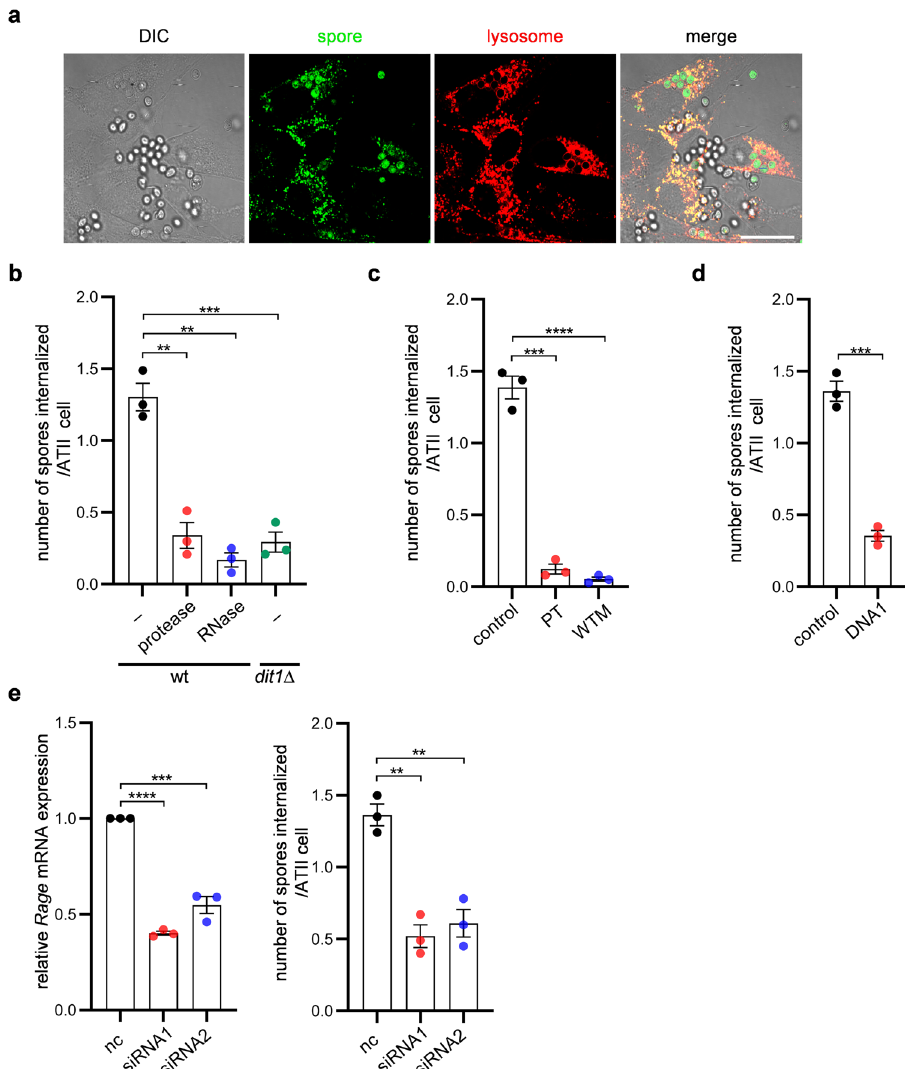
Fig. 6 Spores are internalized in primary mouse ATII cells. a Representative images of ATII cells with internalized spores. Images were obtained with differential interference contrast (DIC) or fl uorescence microscopy (spore and lysosome). Lysosomes were stained with LysoTracker Red. Scale bar, 20 µ m. b Internalization of wild-type (wt) or dit1 Δ spores in ATII cells. Wild-type (wt) or dit1 Δ spores without any treatment ( − ), wild-type spores treated with protease or RNase A (RNase) were incubated with ATII cells. c Internalization of spores in ATII cells treated with or without (control) piceatannol (PT) or wortmannin (WTM). d Spore internalization in ATII cells in the presence or absence (control) of DNA1. e Left panel: Levels of the Rage mRNA in primary mouse ATII cells transfected with two Rage -targeting siRNAs (siRNA1 and siRNA2) or a nontargeting siRNA control (nc). The ratios of Rage mRNA levels in cells transfected with Rage -targeting siRNAs to those in cells transfected with nc are shown. Right panel: Internalization of spores in Rage knockdown- and nc-transfected ATII cells. Data were presented as the mean ± SEM ( b – e ). Statistical signi fi cance was determined by two-tailed unpaired Student ’ s t